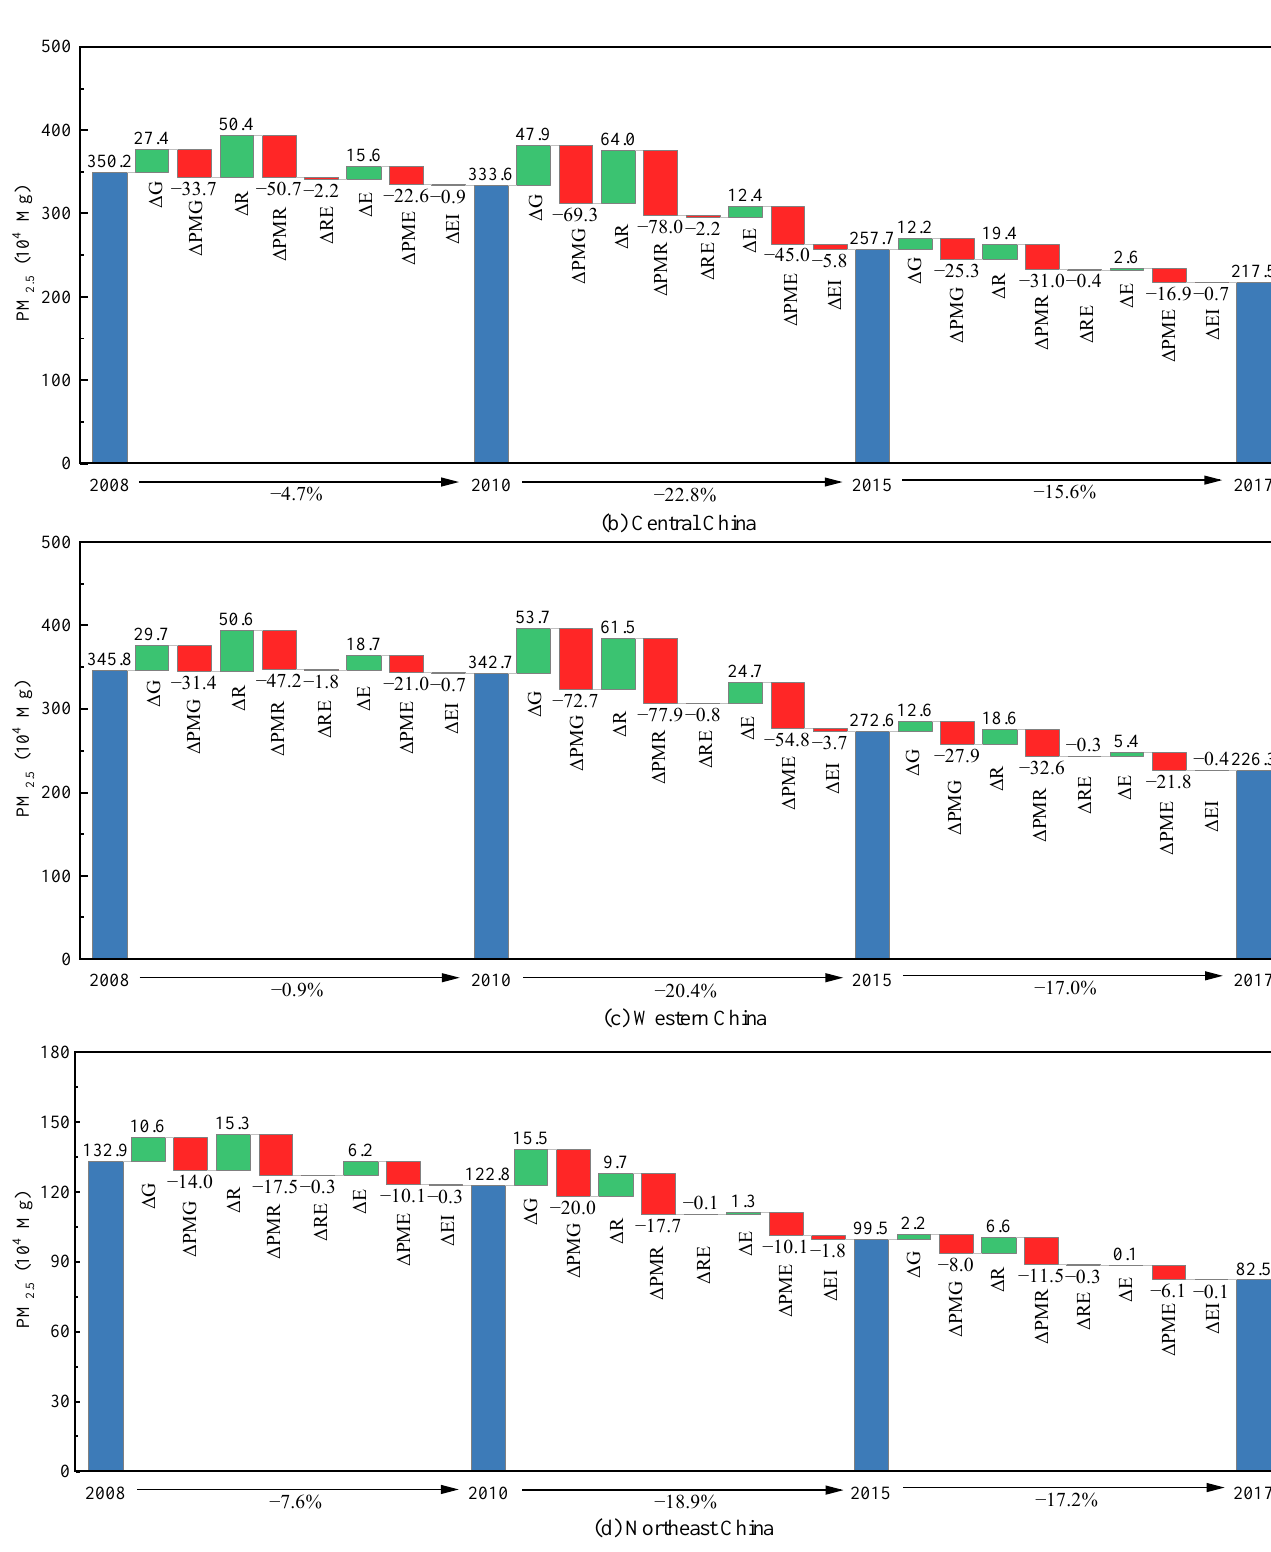
Figure 3. Decomposition results of the four subregions over different periods ( ∆ G , ∆ PMG , ∆ R , ∆ PMR , ∆ RE , ∆ E , ∆ PME and ∆ EI denote the effects of changes in GDP, emission intensity, innovation input scale, innovation input PM 2.5 intensity, innovation input efficiency, energy consumption scale, emission coefficient, and energy intensity on the changes in PM 2.5 emissions, respectively).